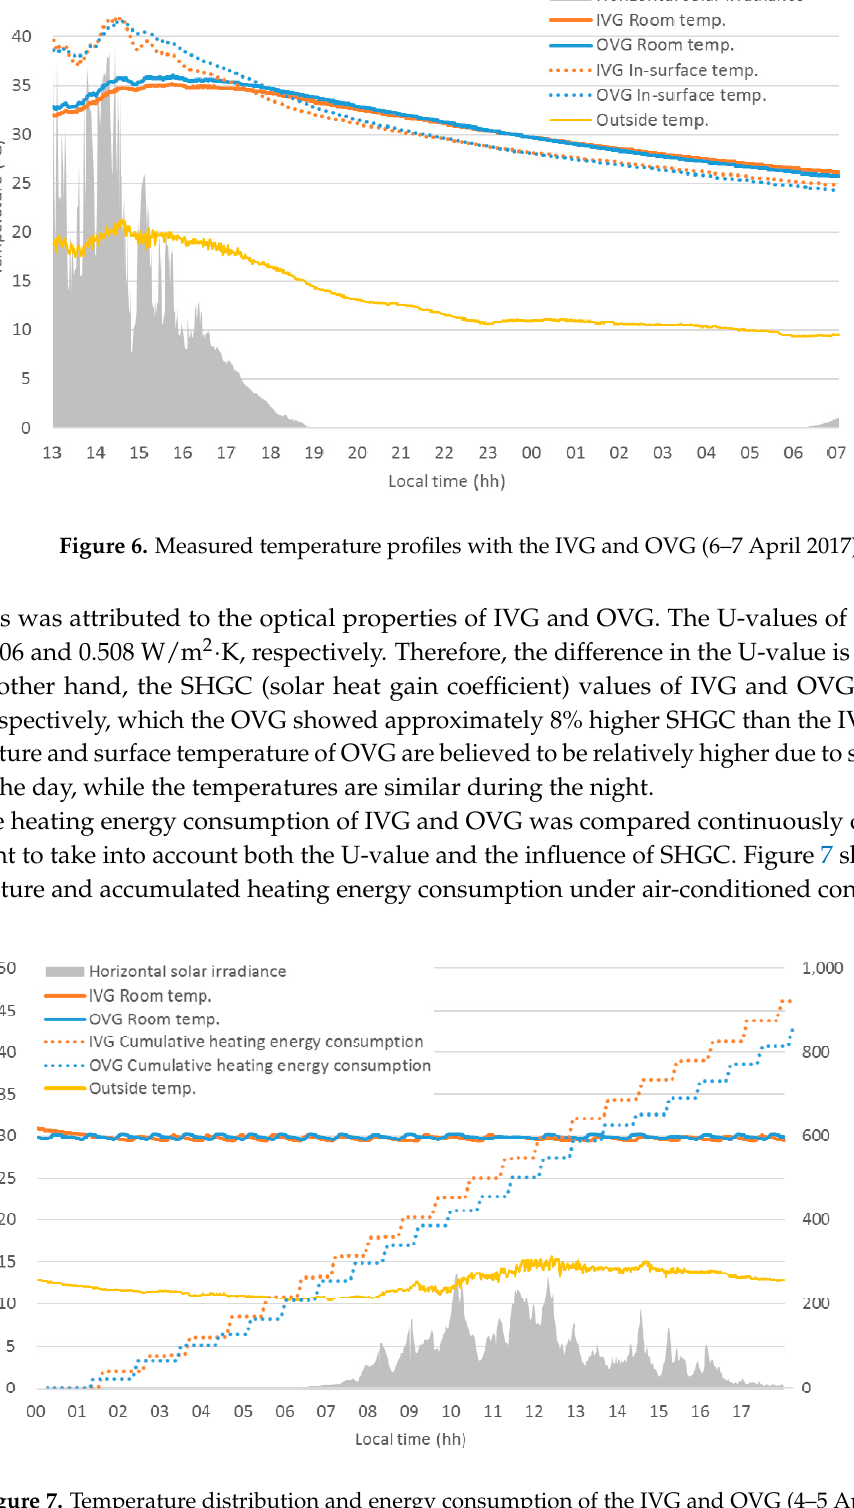
Figure 7. Temperature distribution and energy consumption of the IVG and OVG (4–5 April